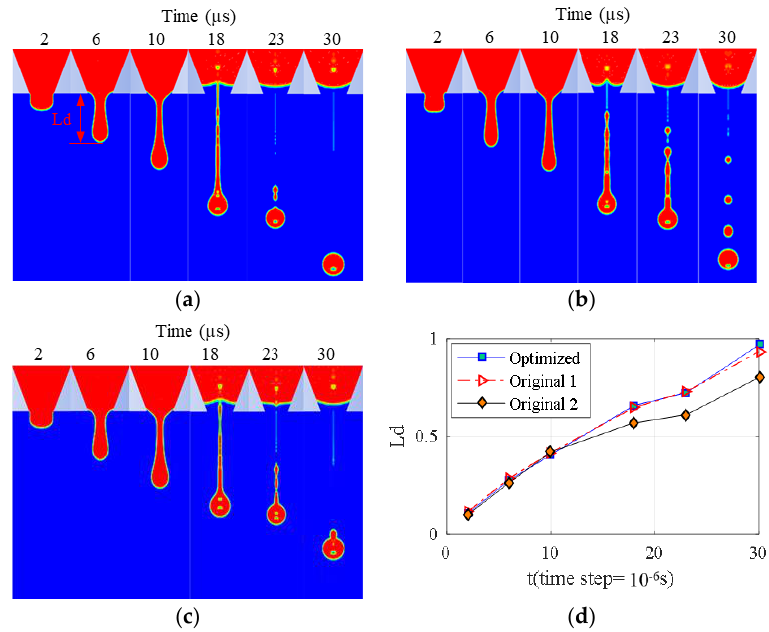
Figure 15. Comparison between the optimized model and the original model. ( a ) Droplet ejection counters of the optimized model. ( b ) Droplet ejection counters of the original Model 1. ( c ) Droplet ejection counters of the original Model 2. ( d ) Comparison of the droplet length.